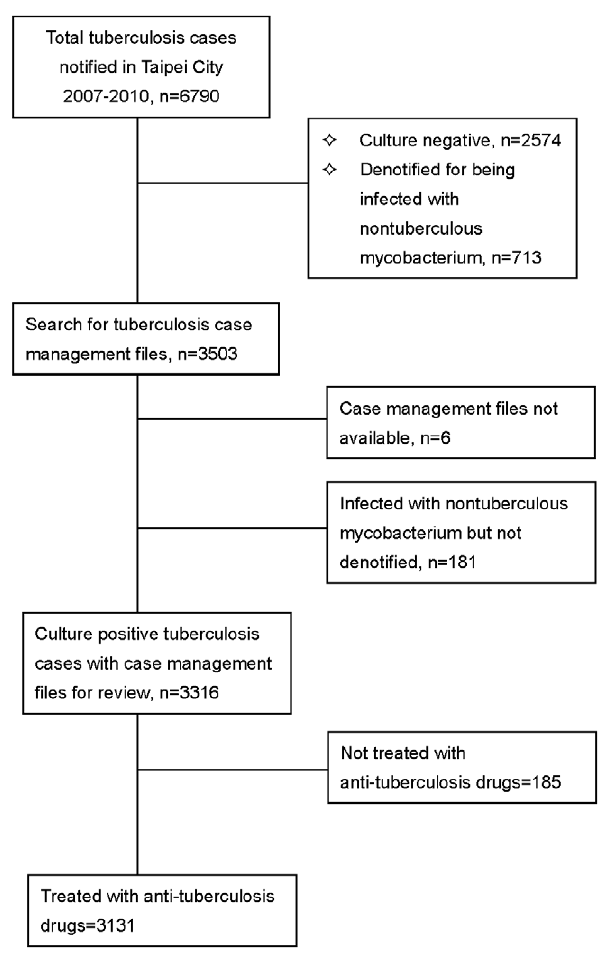
Figure 1. Flow chart of study population.